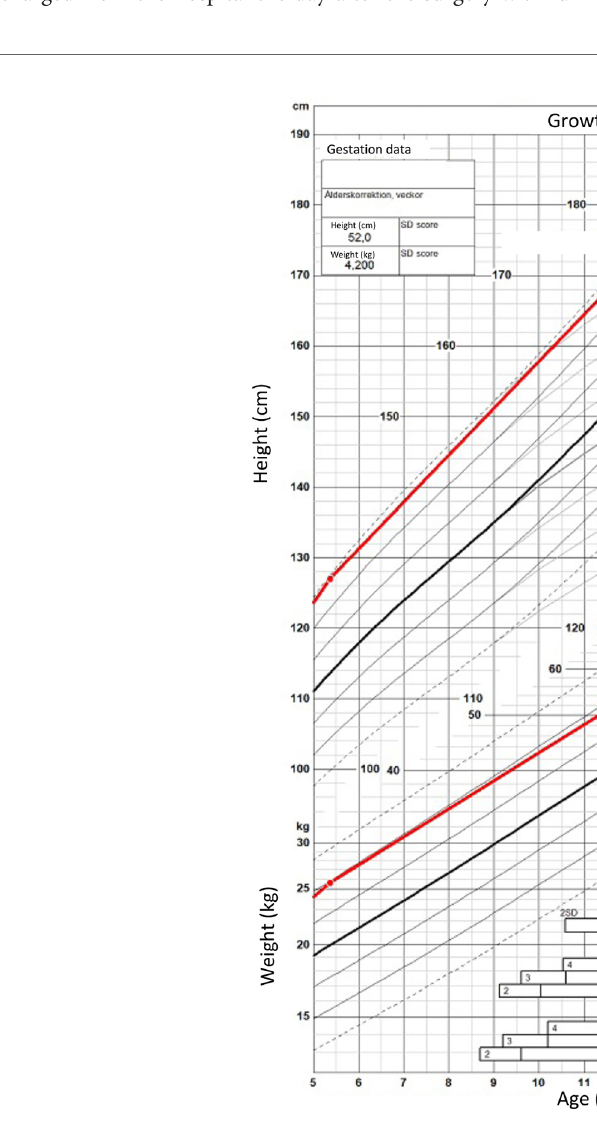
FIGURE 1 | Height and weight growth chart from 5 to 18 years of age for the